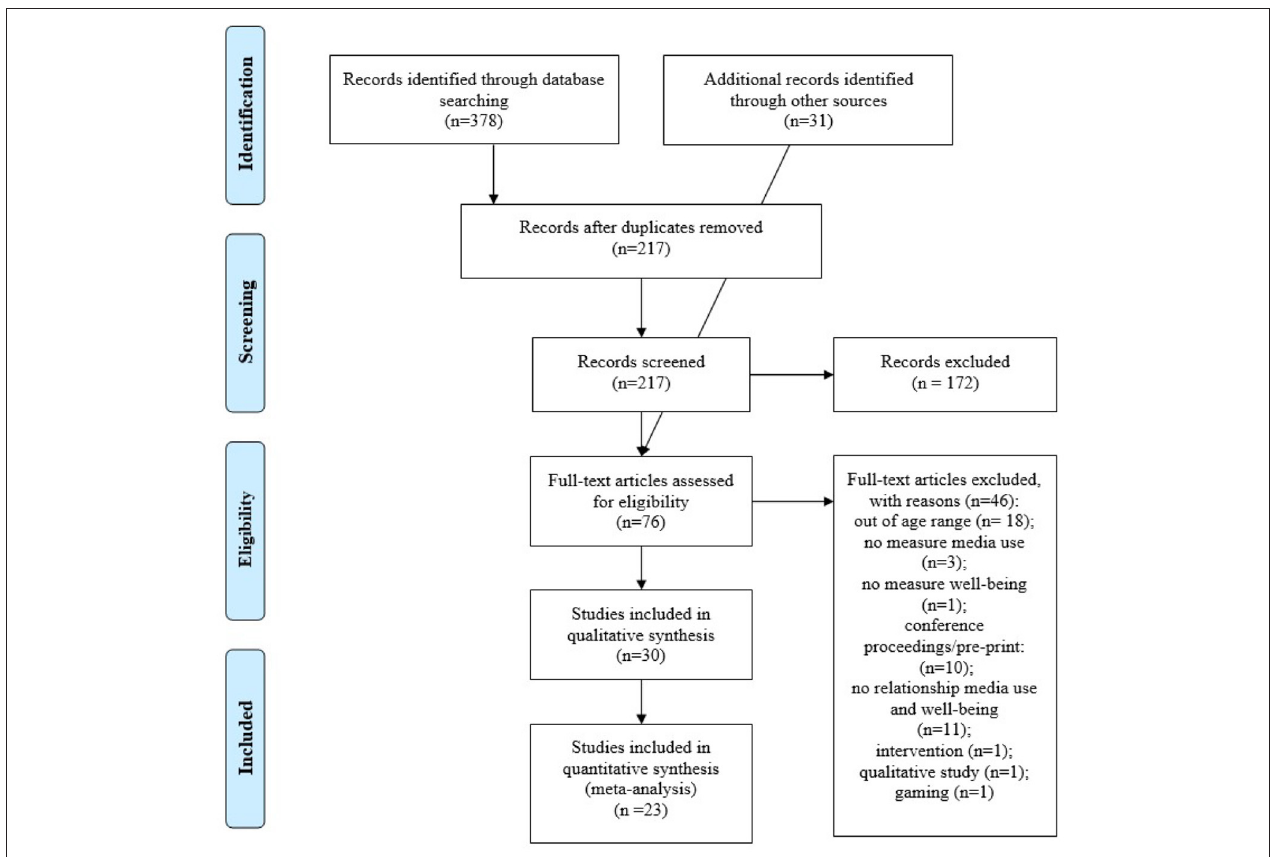
FIGURE 1 | PRISMA